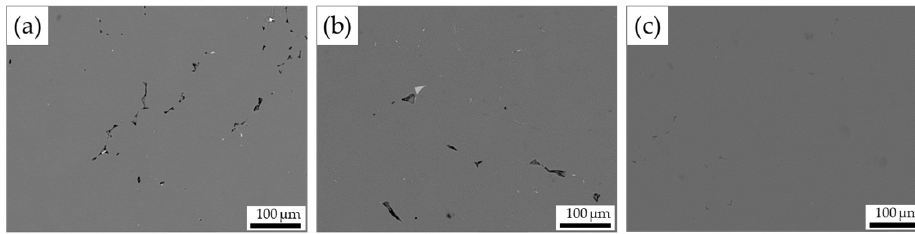
Figure 3. SEM microstructure images of Al-6Mg alloy sample after being purified: ( a ) non-vacuum static melt treatment, ( b ) non-vacuum rotary-injection purification, ( c ) vacuum-stirring purification.